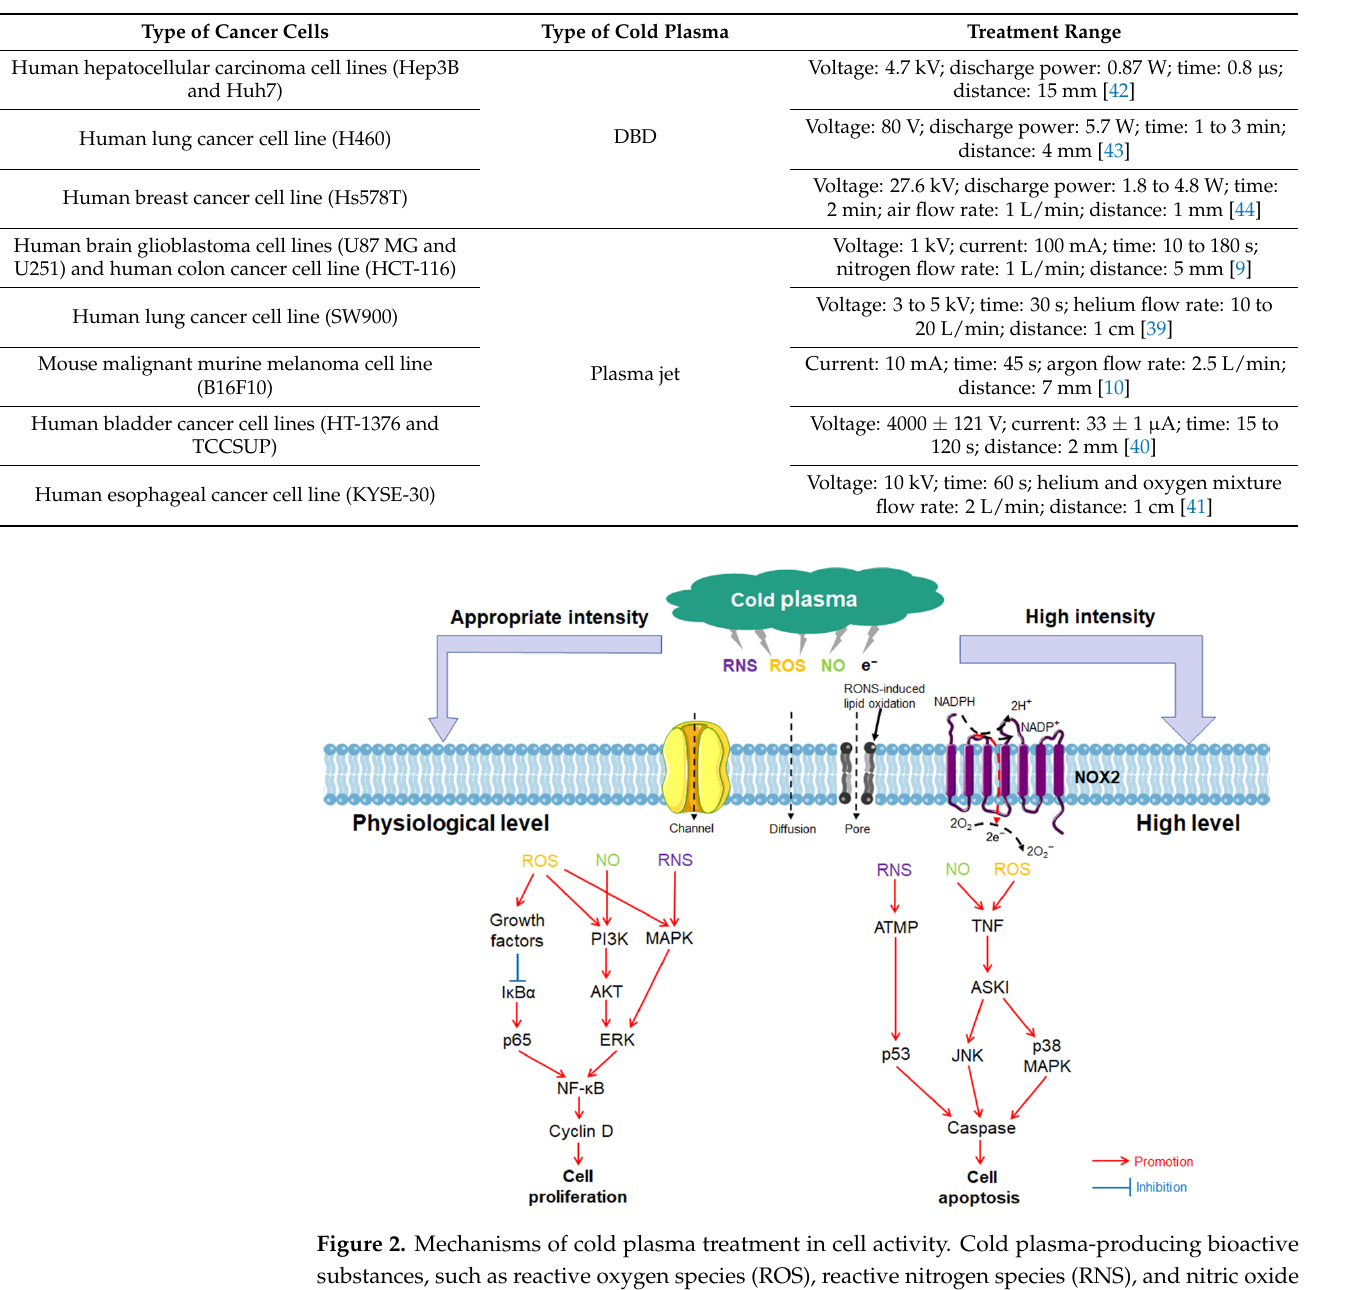
Table 2. Cold plasma treatment ranges for different cancer cells.